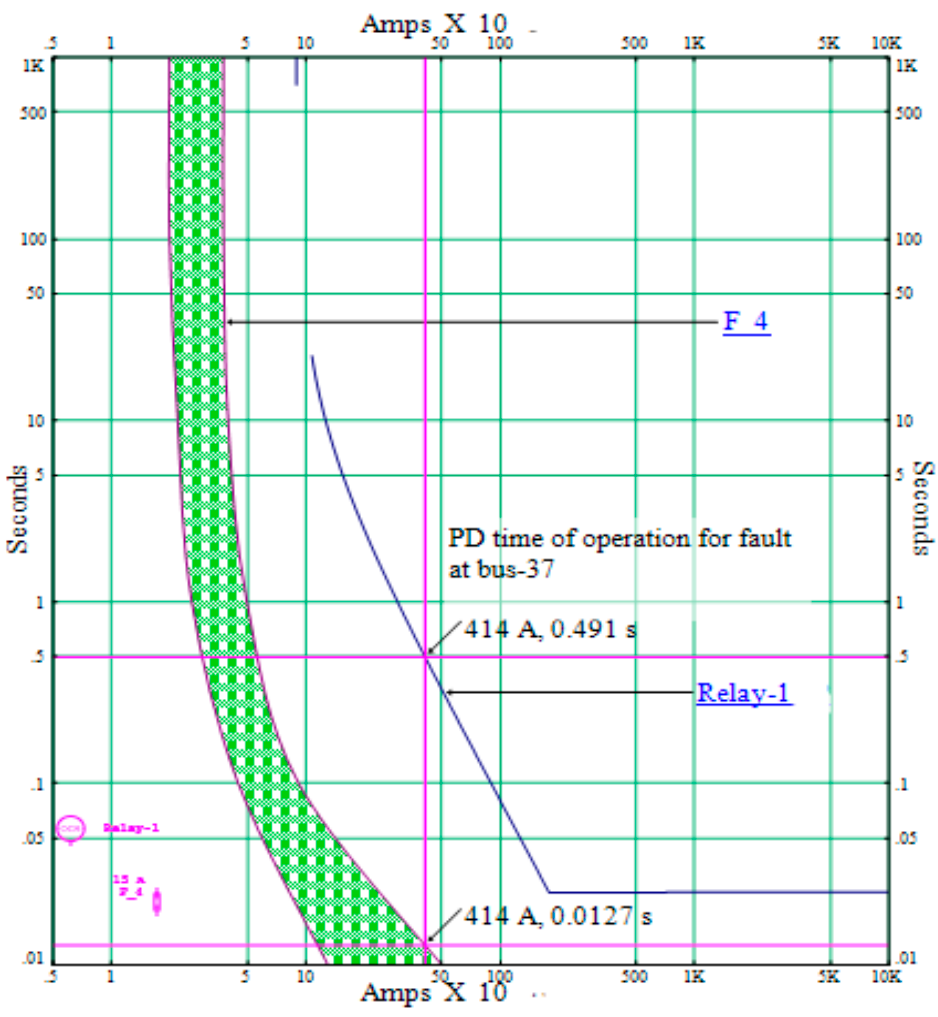
Figure 8. Log–log diagram of the relay and downstream fuse 4. Table 4. Simulation result of SR considering protection